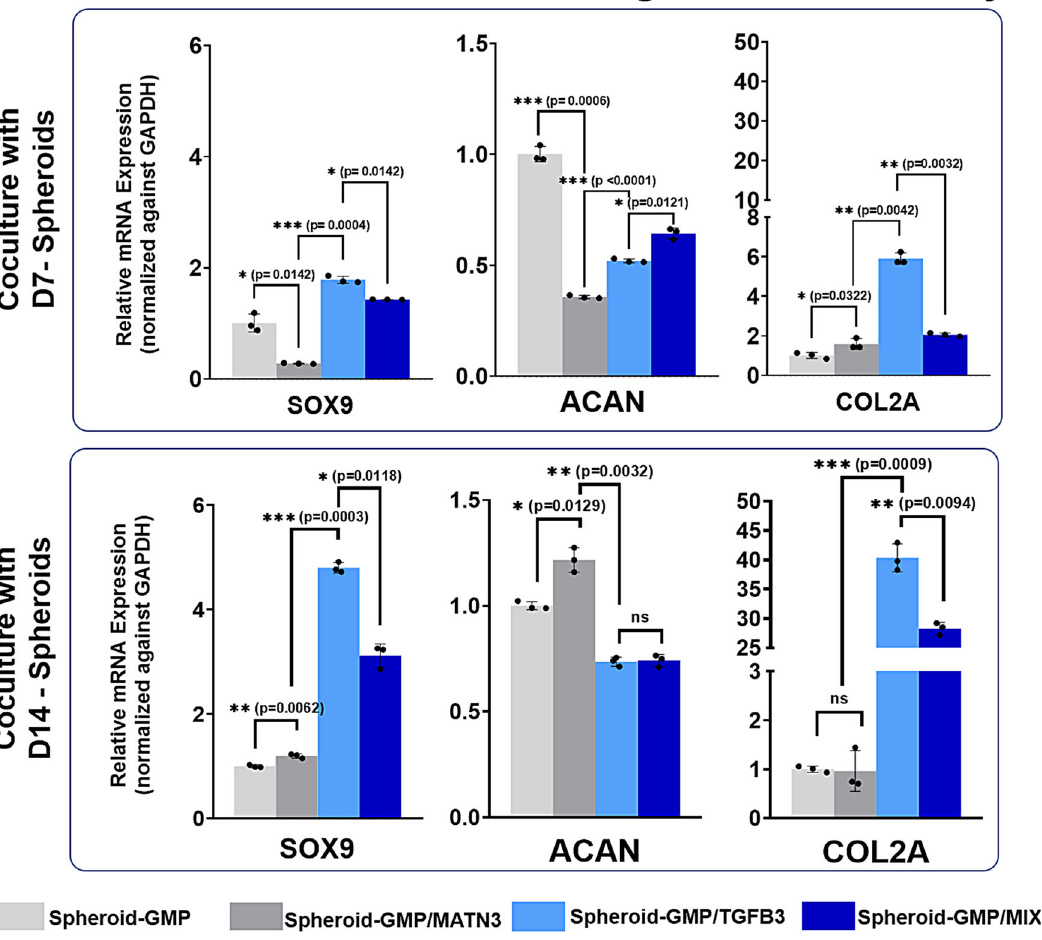
Fig. 8 Expression of chondrogenic markers in degenerated chondrocytes cocultured with D7 and D14 spheroids. Quantitative real-time gene expression analysis of the chondrogenic markers SOX9, ACAN, and COL2 in degenerated chondrocytes cocultured with D7 and D14 spheroids. RT-PCR data were normalized against GAPDH expression. The data are representative of three independent experiments in triplicate. Error bars denote the means ± standard error of mean (sem) (ns = not signi fi cant, * p < 0.05, ** p < 0.01, *** p < 0.001; **** p < 0.0001). Individual data points and p -values for signi fi cance are indicated in the